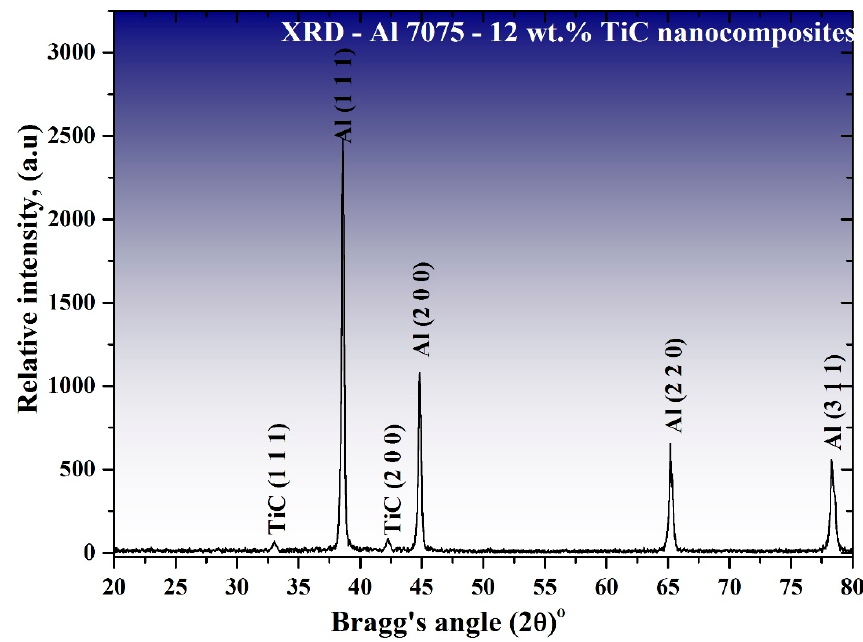
Figure 3. XRD pattern of Al–12 wt.% TiC